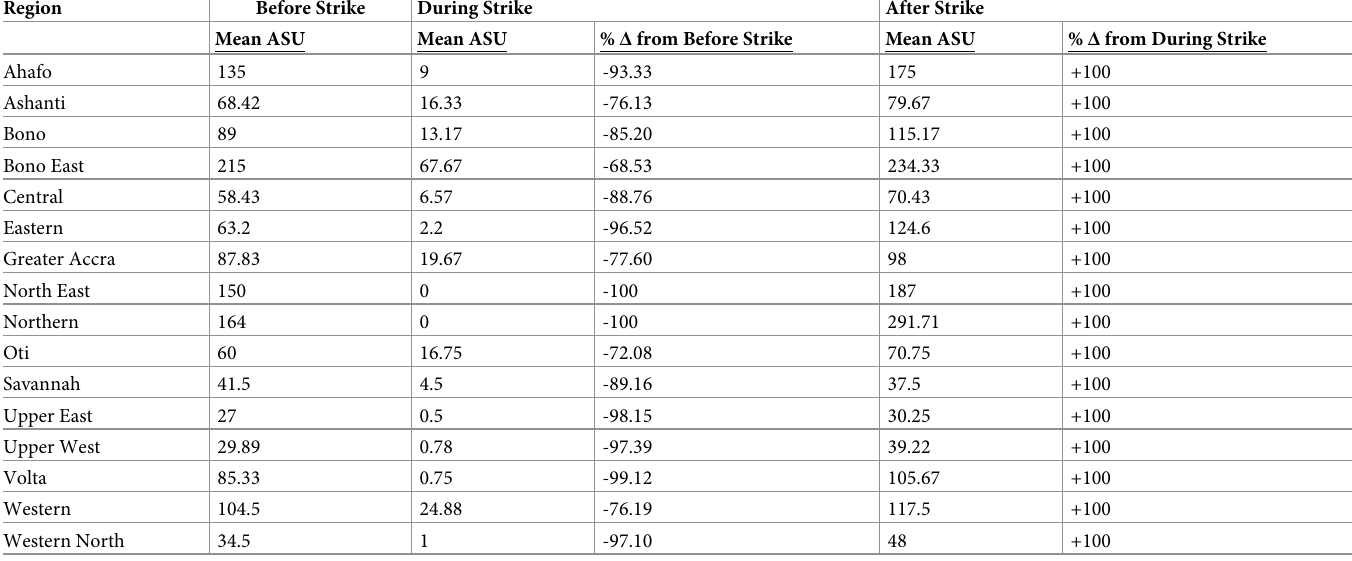
Table 7. Percentage change in the mean antenatal clinic service use (ANC) during and after strike. Region Before Strike During Strike After Strike Mean ASU